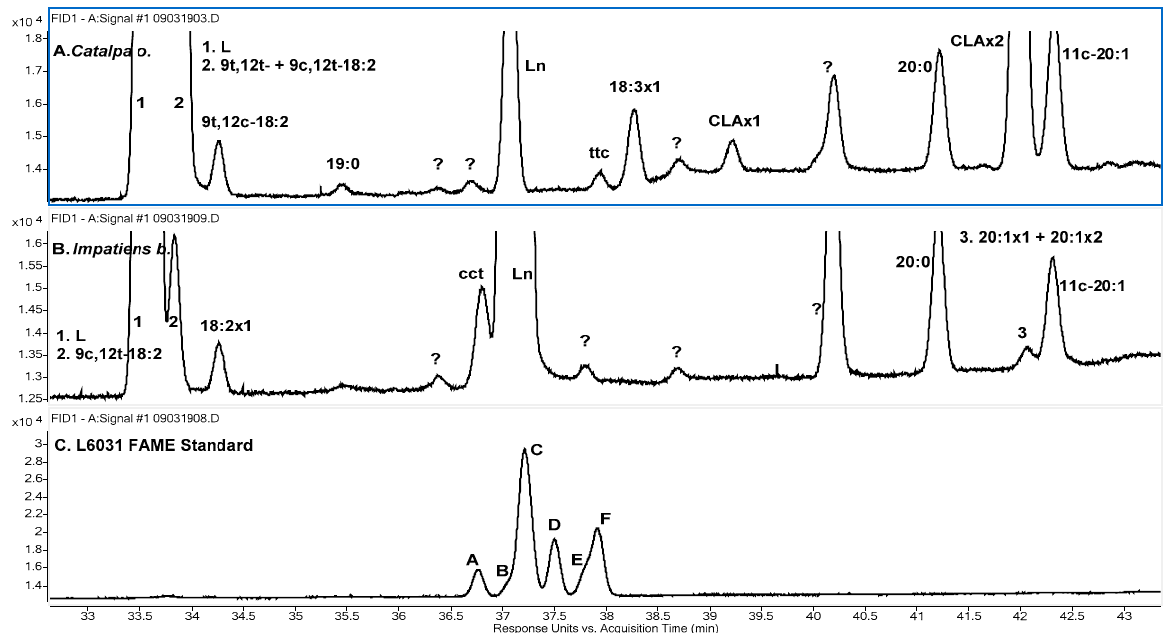
Figure 3. Chromatograms showing the 18:2 and non-conjugated 18:3 isomers on the SP-2560 column. ( A ) FID of Catalpa o. ( B ) FID of Impatiens b. ( C ) FID of L6031 standard containing the eight geometric 9,12,15-18:3 isomers. The configuration of the L6031 peaks is A ttt ; B ctt ; C tct ; D ttc and cct ; E ctc ; F tcc ; G ccc . Peaks marked ‘ ?’ in 3A and3 are unknowns for which MS evidence is not sufficient to support identification.